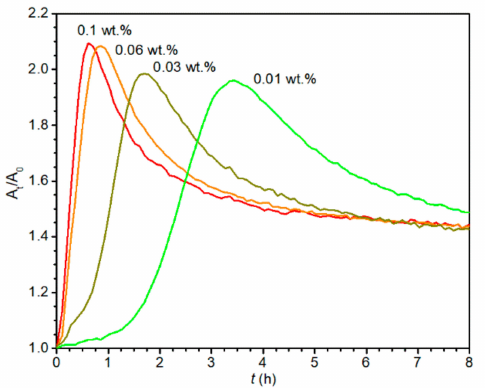
Figure 3. Time development of the infrared band ω ( cis - trans -C = C–H ) at 989 cm − 1 attributed to conjugated double bond system.